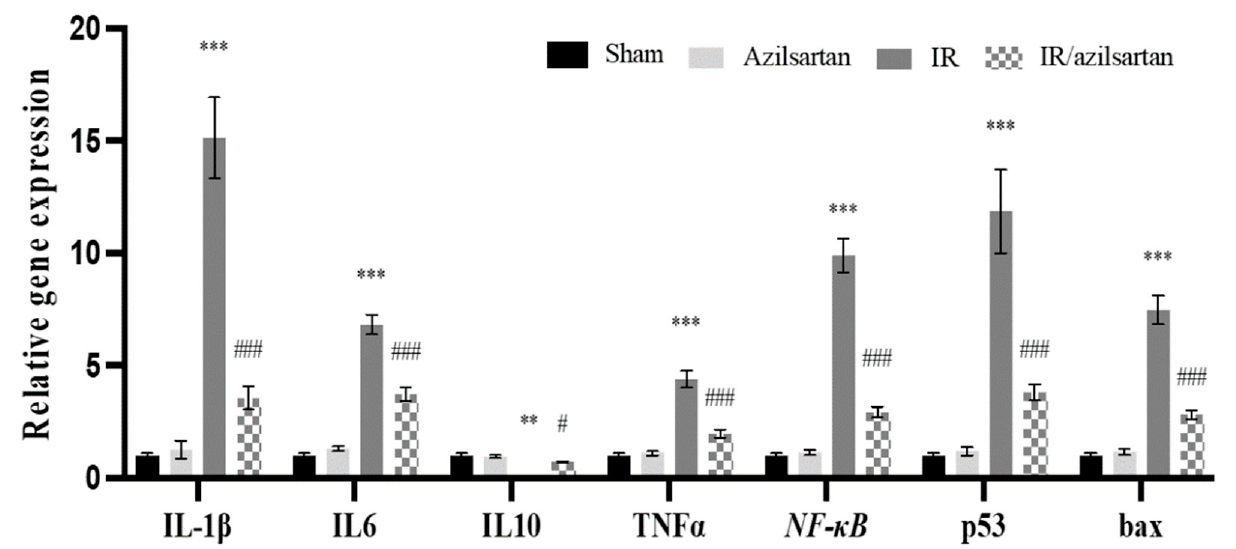
Figure 3. The renal expression of IL-1 β , IL6 , IL10 , TNF- α , NF- κ B , p53 , and bax genes. Quantitative RT-PCR was used to investigate the gene expression of different groups. Expression was represented relative to the untreated sham group and normalized to the corresponding GAPDH gene expression. Bars represent mean ± SD. Followed by post hoc Dunnett test, significant difference was analyzed by two-way ANOVA test, where **; p < 0.01, ***; p < 0.001, compared to the sham group, and #; p < 0.05, ###; p < 0.001, compared to the IR group. IL; interleukin, TNF- α ; tumor ne-